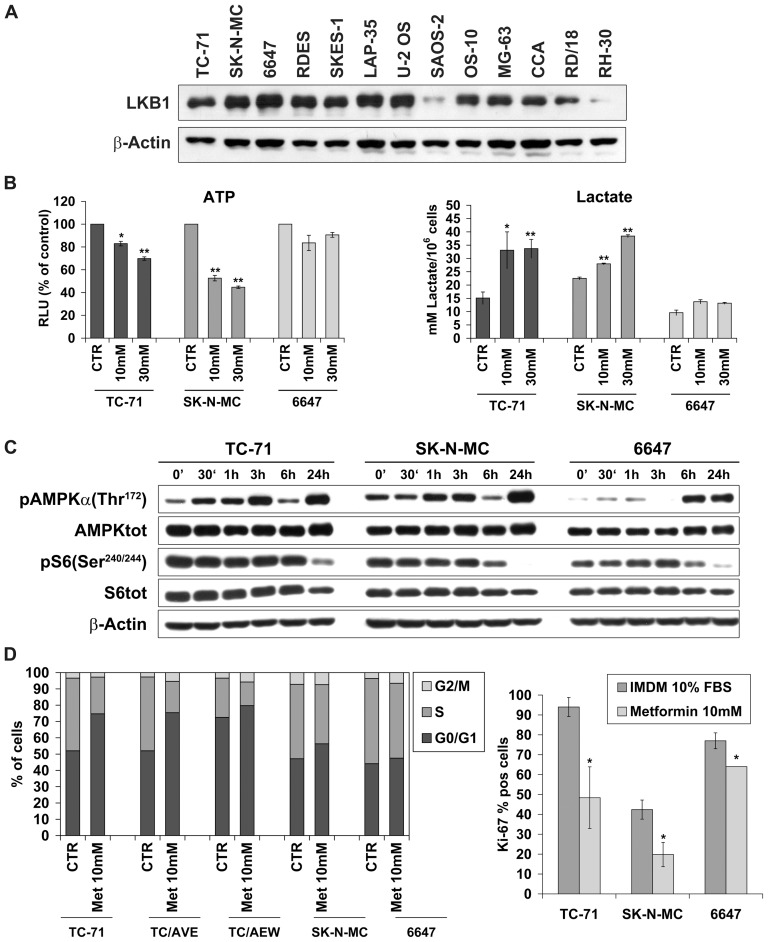
Analysis of metformin targets in Ewing sarcoma cell lines.
A) protein expression levels of LKB1 in a panel of Ewing and osteosarcoma cell lines. β-Actin was used as loading control. B) Left Graph showing cellular ATP levels (RLUs) as a percentage of control in control and metformin treated ES cells. Right ES cells were treated as described in material and methods, and cellular lactate levels were measured using a colorimetric assay kit (Abcam). Graph shows L-lactate concentration. Values are expressed as mean ± SEM and significance (*) p<0.05; (**) p<0.01 as indicated. C) Metformin activity on AMPK and mTOR signaling on Ewing sarcoma cell lines. Western Blotting analysis of metformin-treated cells TC-71, SK-N-MC and 6647. Cells were treated with metformin (10 mM) for the indicated time points (30min-24h). Immunoblot analysis was carried out using antibodies against phosphorylated AMPKα (Thr172), AMPKα, phosphorylated pS6K (Ser240/244), pS6, and β-actin as normalization. D) Analysis of Metformin (10 mM) effects on cell cycle over 48h treatment in three Ewing sarcoma cell lines (TC-71, SK-N-MC, 6647), together with two anti-IGF1R agents resistant cells (TC/AVE, TC/AEW). Left panel, mean percentage of cells in different cell cycle phases as determined by flow cytometry analysis; Righ panel, Ki-67 positive cells (Ki-67 labeling index). Data are shown as percentages of mean of three independent experiments and significance (*) p<0.05 as indicated.